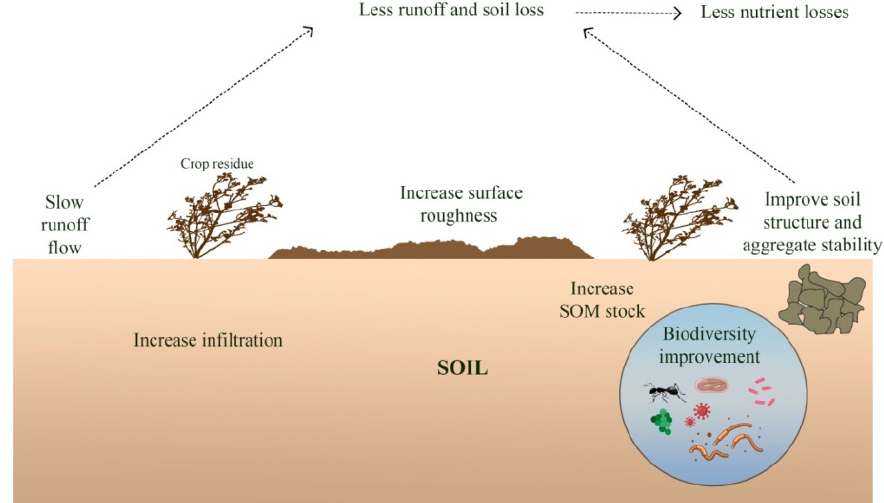
Figure 4. Effect of conservation agriculture on water erosion.